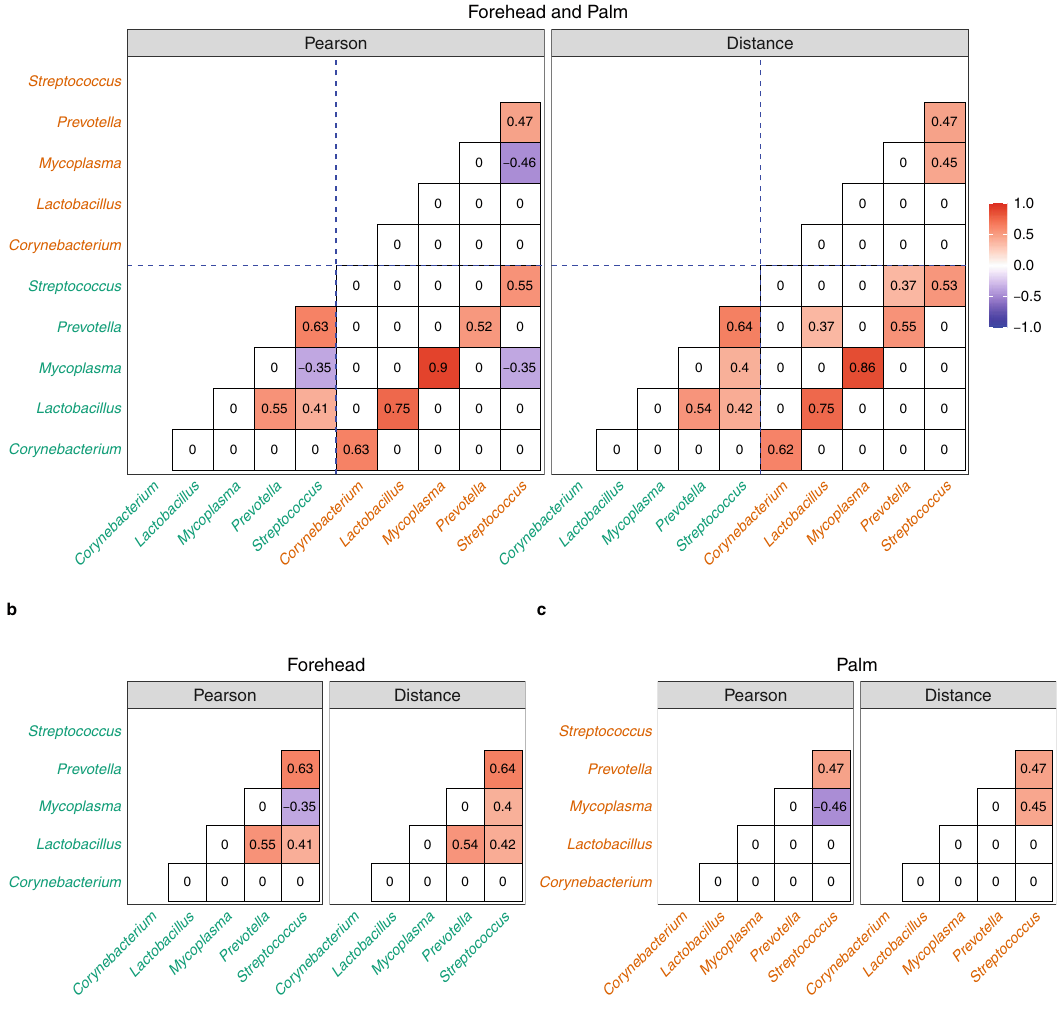
selectedfor visualizationpurposes.Generafrom the foreheadarecolored in green and genera from the palm are colored in brown in the x and y axes. Blue dashed lines in a are used to separate genera between forehead and palm. The correlation coef fi cient ranges from − 1 to 1, color-coded by blue to red,